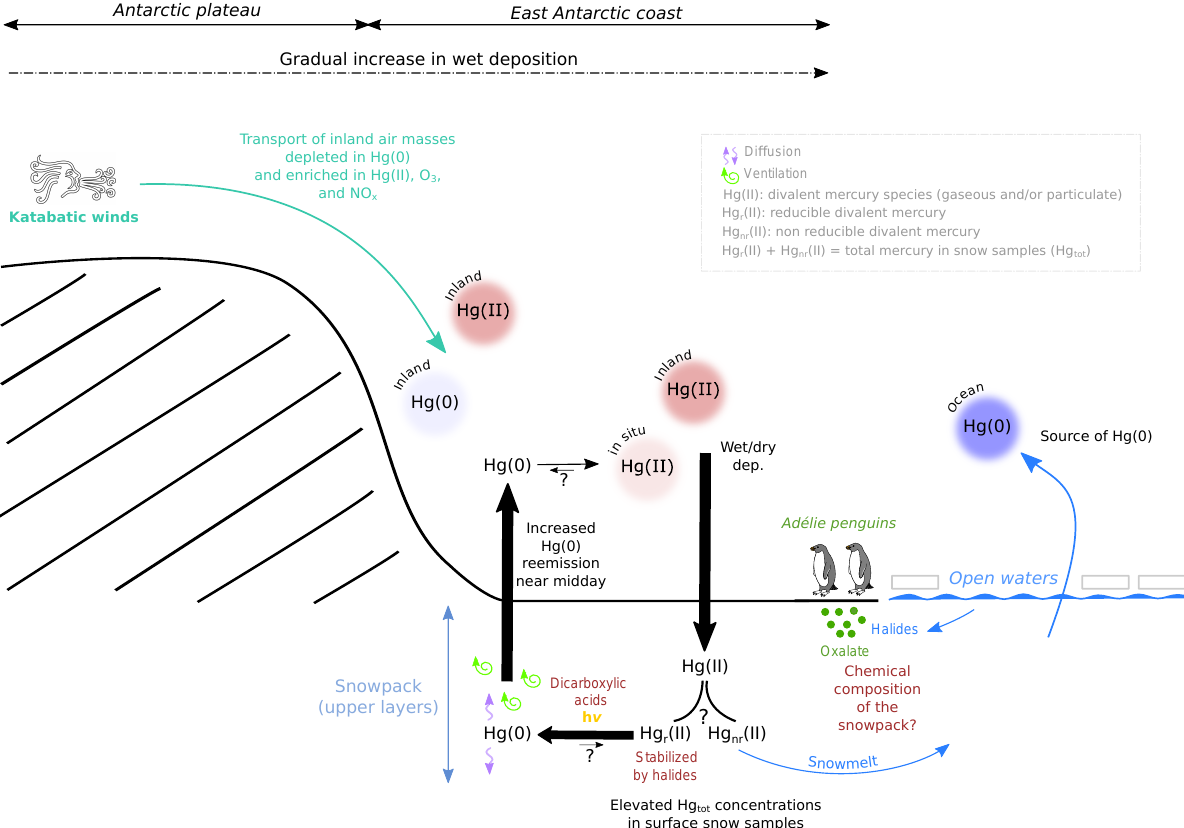
Figure 6. Schematic diagram illustrating the processes that may govern the mercury budget at DDU in summer. Katabatic winds transport inland air masses enriched in oxidants and Hg(II) toward the coastal margins. Hg(II) species deposit onto the snowpack by wet and dry processes leading to elevated concentrations of total mercury in surface snow samples. A fraction of deposited mercury can be reduced (the reducible pool, Hg r (II)) in the upper layers of the snowpack and subsequently reemitted to the atmosphere as Hg(0). Hg(0) emission from the snowpack maximizes near midday likely as a response to daytime heating. The chemical composition of the snowpack (halides, dicarboxylic acids) may influence the reduction rate of Hg(II) species within the snowpack. The ocean may be a net source of Hg(0) to the